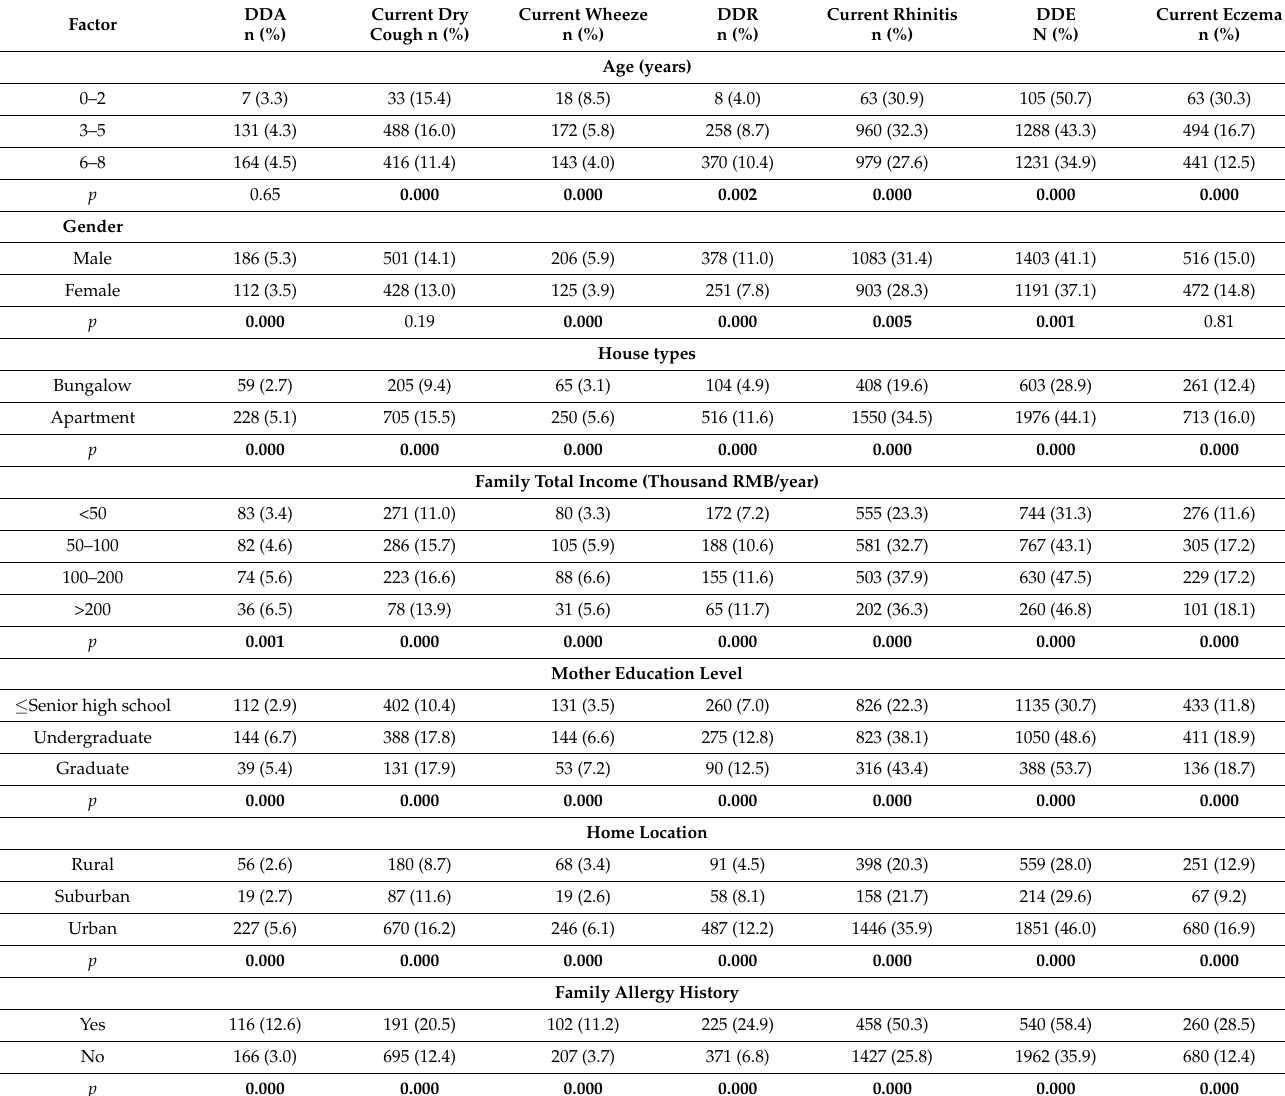
Table 3. Associations between sociodemographic factors, and children’s allergic diseases using the Chi-square